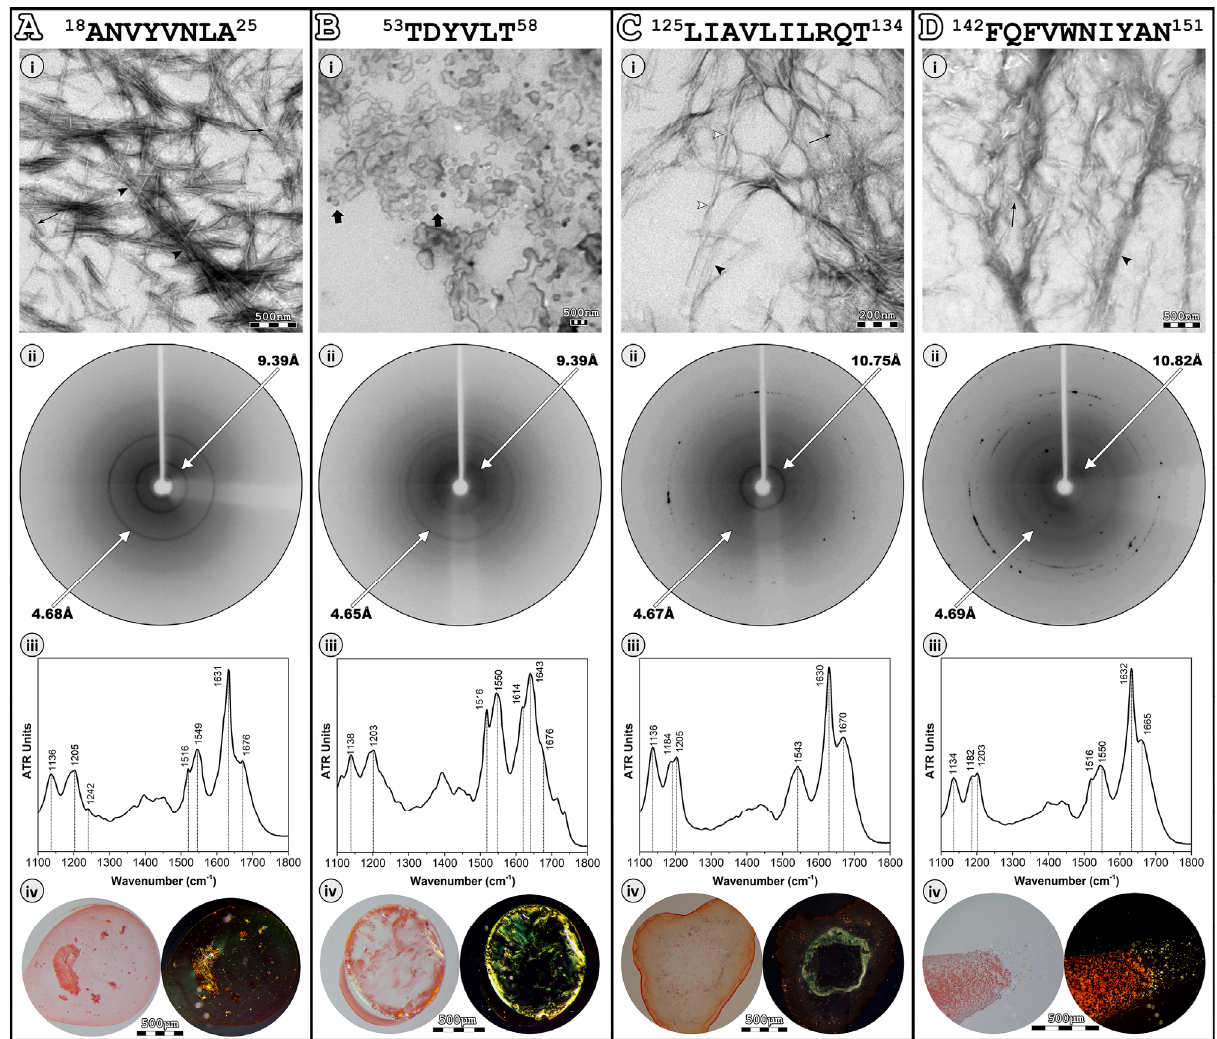
Figure 2. Experimental results of the four peptide-analogues ( A – D ). 18 ANVYVNLA 25 ( Ai ), 125 LIAVLILRQT 134 ( Ci ) and 142 FQFVWNIYAN 151 ( Di ) self-assemble into straight and unbranched amyloid-like fibrils, with a diameter of approximately 100 Å (black arrows), which tend to interact laterally forming straight and twisted ribbons (black and white arrowheads, respectively). 53 TDYVTL 58 ( Bi ) forms amorphous and spherical (flat black arrows) aggregates. All X-ray diffraction patterns ( Aii – Dii ) are indicative of the “cross- β ” structure, displaying a re fl ection at approximately 4.7 Å and a re fl ection at 9.39 Å, 9.39 Å, 10.75 Å, and 10.82 Å, corresponding to the distance between consecutive β -strands and the distance between packed β -sheets, respectively. ATR FT-IR spectra (1100–1800 cm − 1 ) produced from thin hydrated fi lms of the four peptide-analogues ( Aiii – Diii ) con- fi rm their β -sheet secondary structure. All peptide-analogues exhibit the characteristic apple–green birefringence ( Aiv – Div ) that amyloids typically exhibit.